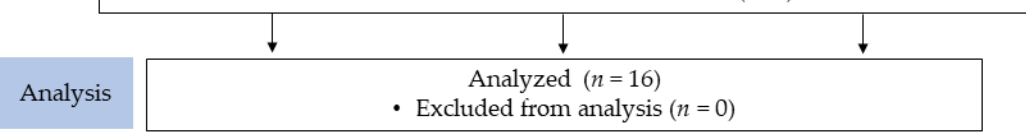
Figure 3. Consolidated Standards of Reporting Trials (CONSORT) diagram for the study trial.